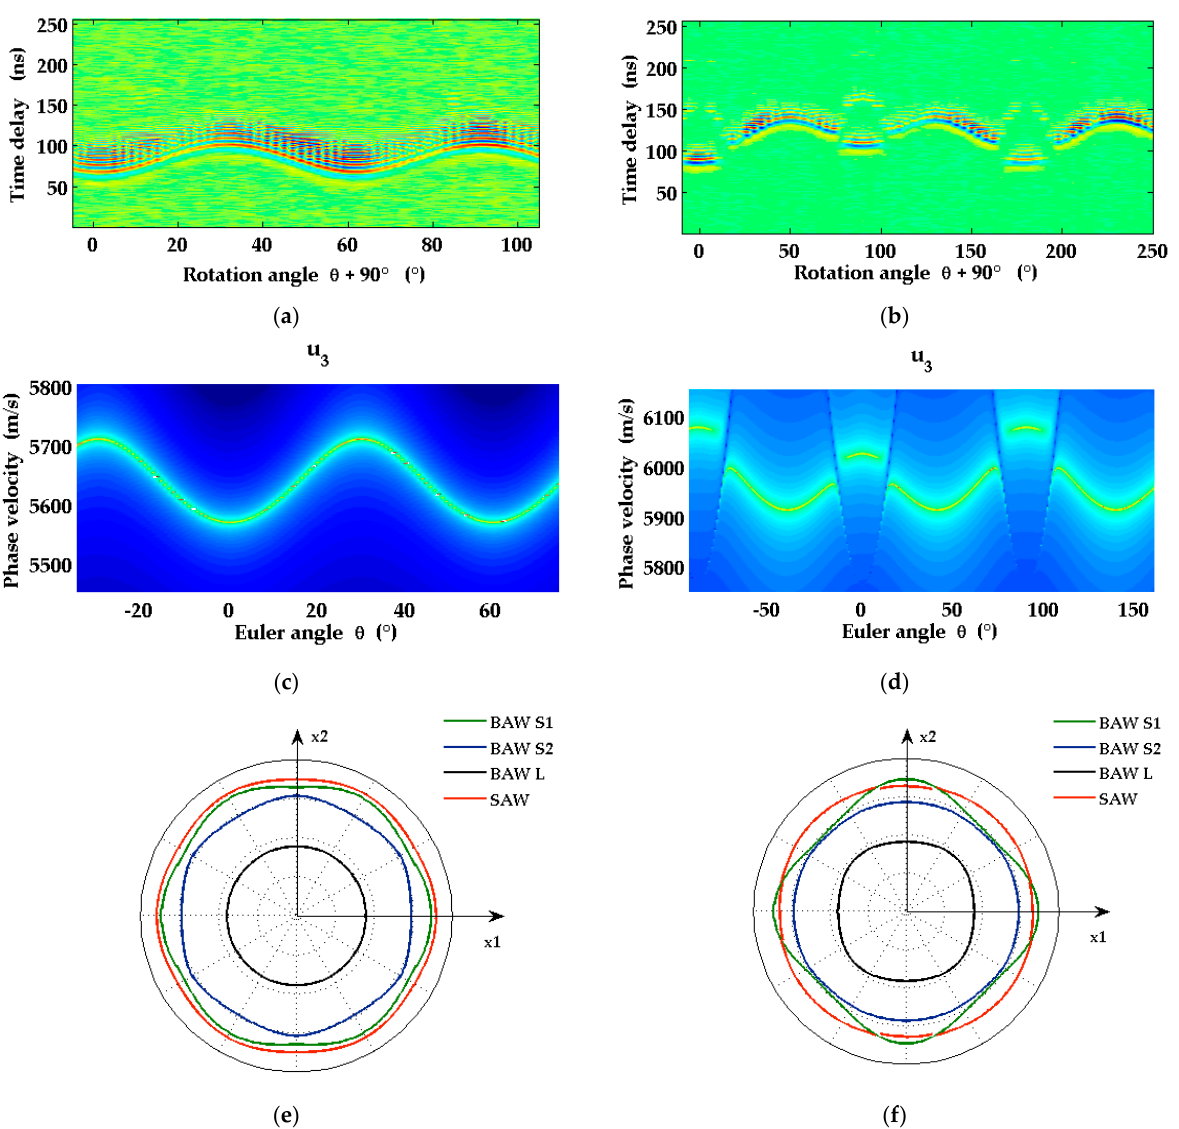
Figure 3. Dependencies on SAW wavevector direction for the sapphire cuts: c-plane Al 2 O 3 (0001) ( a , c , e ) with Euler angles (0 ◦ , 0 ◦ , θ ) and r-plane Al 2 O 3 (1-102) ( b , d , f ) with Euler angles (60 ◦ , 57.6 ◦ , θ ). Measured signal on the surface of sample 1 in Table 2 ( a ) and of sample 2 in Table 2 ( b ). Measurements taken at various angles using a rotary positioning table; ( c , d ) show the calculated SAW phase velocities on the surface of pure sapphire crystal as functions of Euler angle θ ; ( e , f ) present the intersections of the slowness surface of bulk acoustic waves with the surface plane (quasi-longitudinal sheet (BAW L), two quasi-shear sheets (BAW S1 and BAW S2)) and the slowness curve for Rayleigh waves (SAW) on pure sapphire as functions of the Euler angle θ